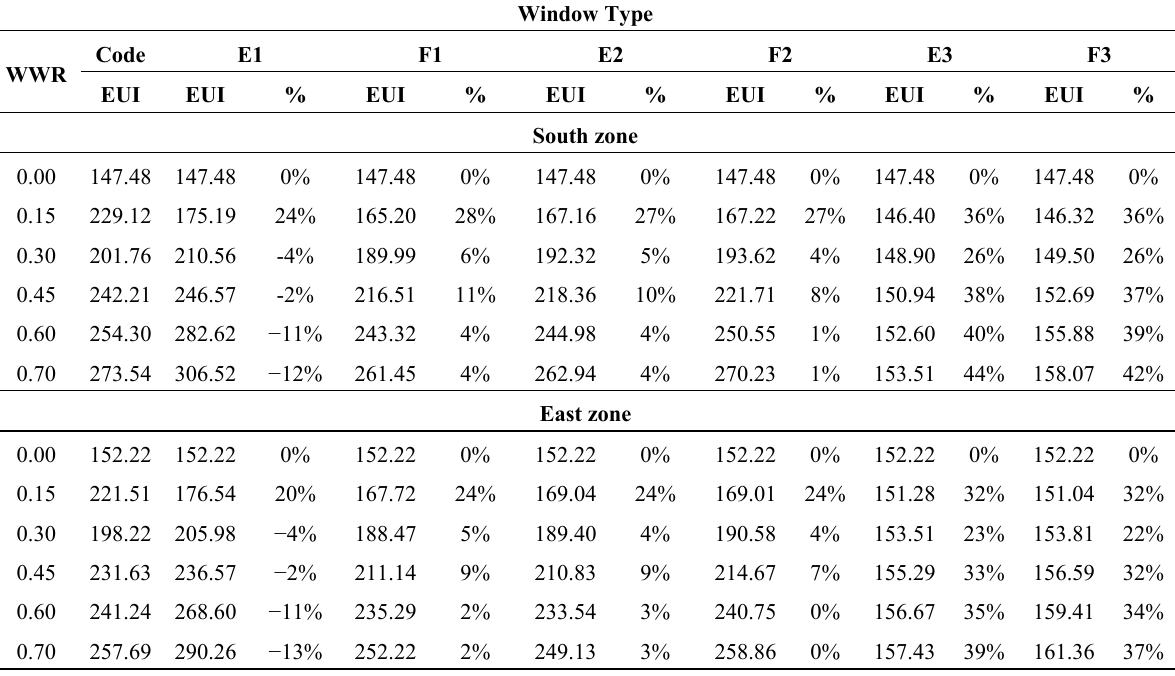
Table 11. Zone sensible cooling load (MJ/m 2 -year) and percent savings compared to the GB 50189-2005 Standard for